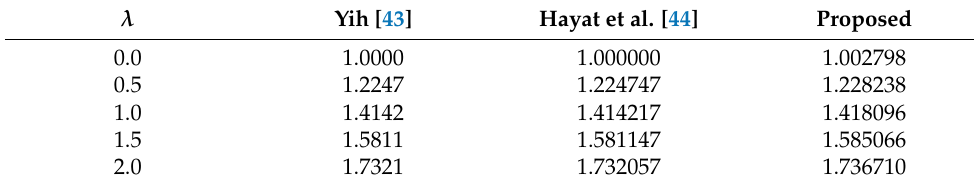
Table 1. Comparison of the proposed scheme with past research for finding numerical values of − f (cid:48)(cid:48) ( 0 ) using β = 100,000, M = E = F r = 0, and N ( no . of grid points ) = 1